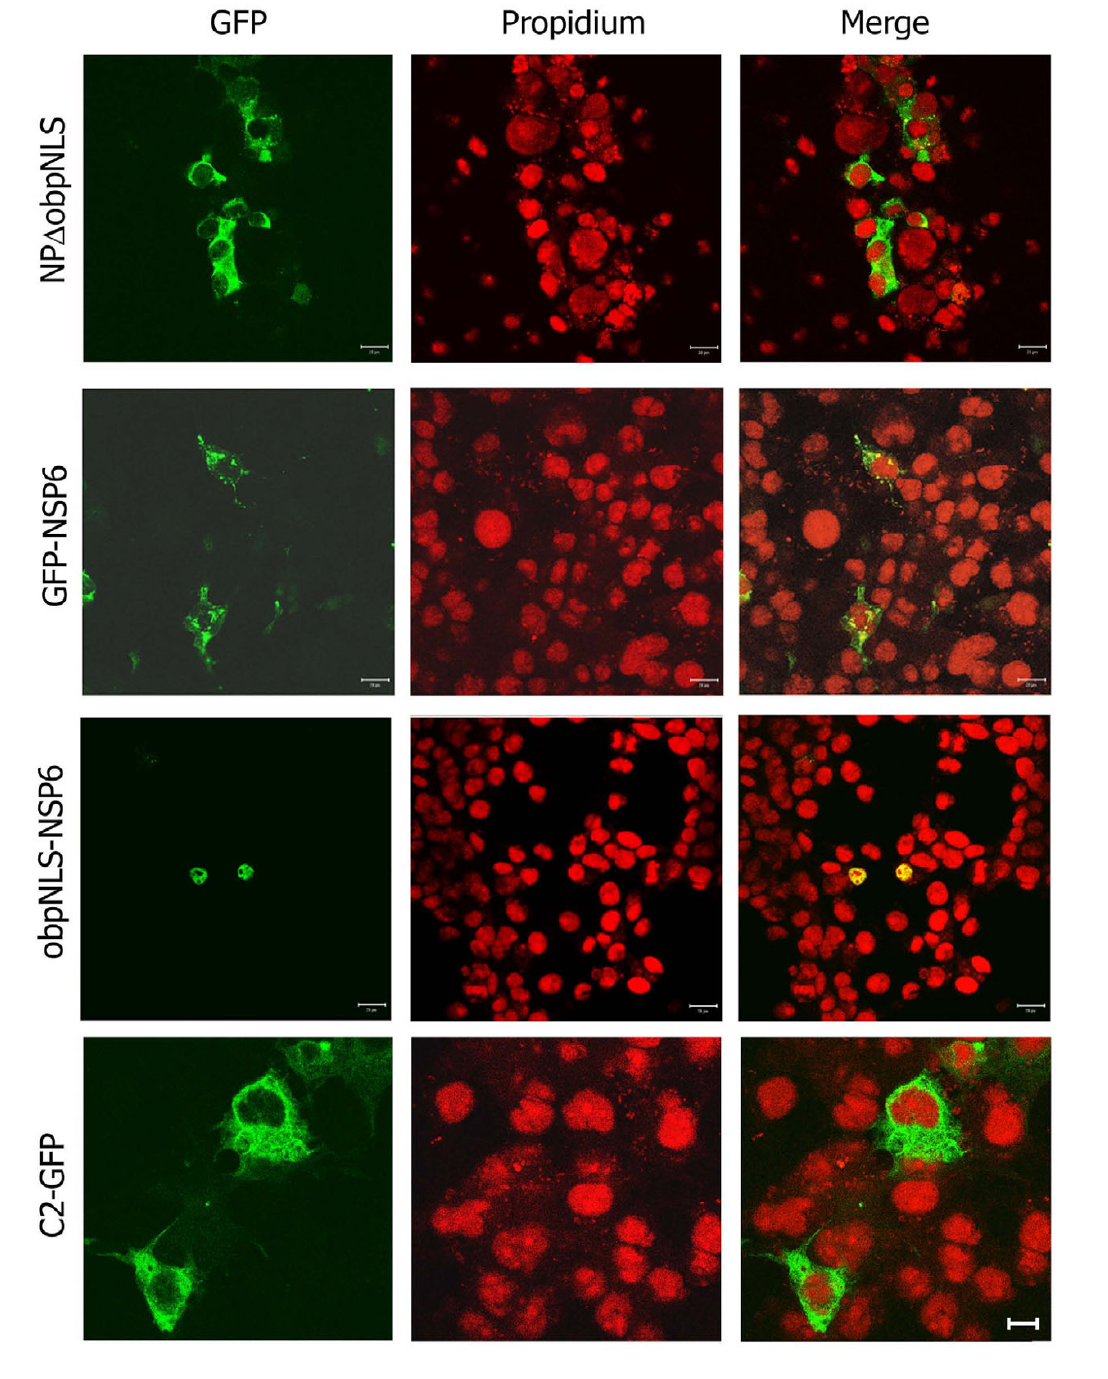
Figure 7 Expression analysis of construct lacking obpNLS and construct with obpNLS in fusion with a known cytoplas- mic protein. NP? obpNLS, transfected in COS-7L cells, exhibits a characteristic cytoplasmic localization pattern. C2-GFP, used as a vector control, localizes to the cytoplasm. Rotavirus non structural protein 6 (NSP6) fused with GFP (GFP-NSP6) exhibits a typical punctate, cytoplasmic localization pattern. However, note that the obpNLS+NSP6 (obpNLS fused to the N- terminus of NSP6) exhibit an exclusive nuclear localization pattern. Bar represents 20